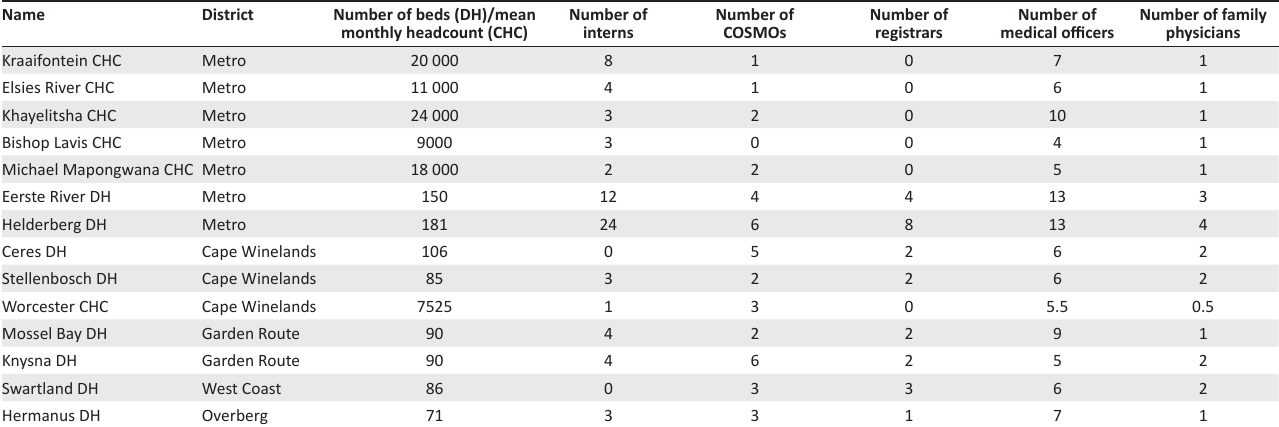
FIGURE 1: Map of the district and sub-districts of Western Cape TABLE 1: Characteristics and location of the study sites.